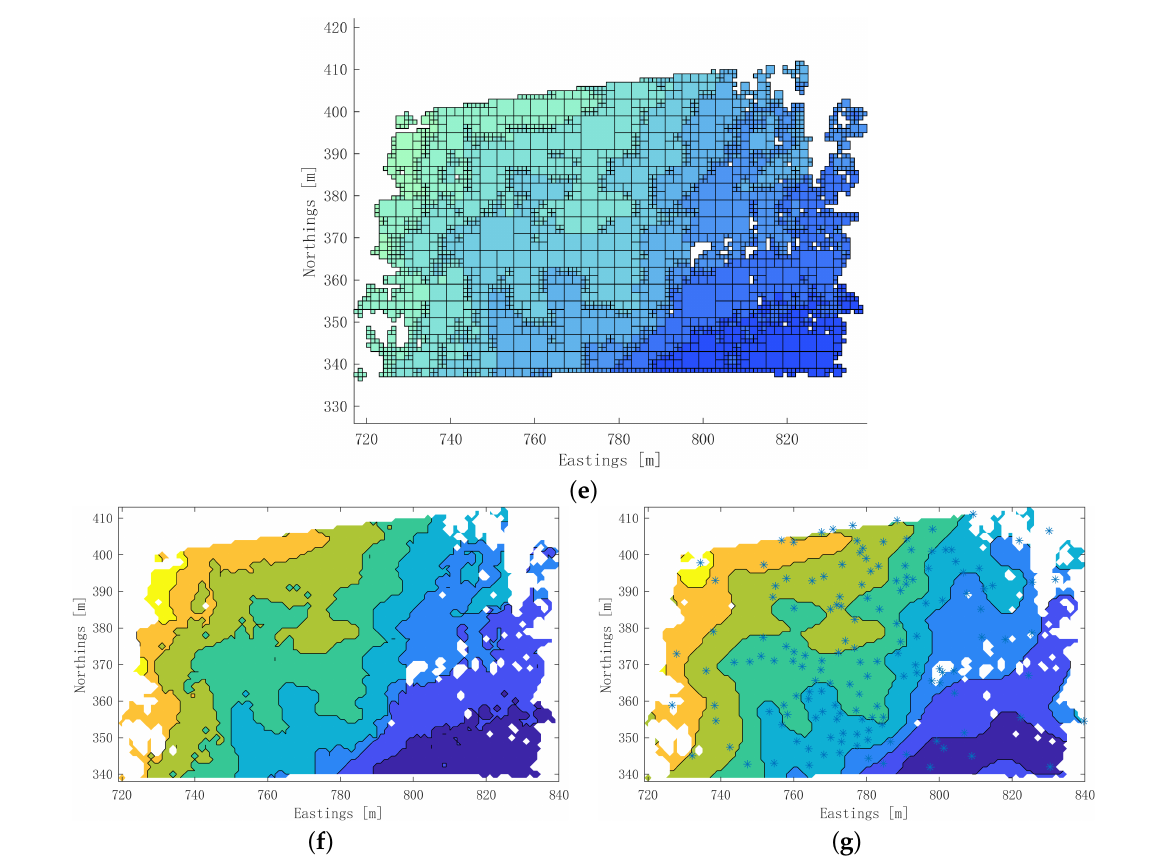
Figure 12. Experimental results of Map #74. ( a ) 3D point cloud map of map #74. ( b ) girding map of map #74. ( c ) SPGPs reconstruction map of map #74. ( d ) Octree-based map of map #74. ( e ) Quadtree- based map of map #74. ( f ) Contour map generated from the girding map ( b ), and so are the outcomes of the Octree-based map ( d ) and Quadtree-based map ( e ). ( g ) Contour map generated from the SPGPs reconstruction map ( c ).